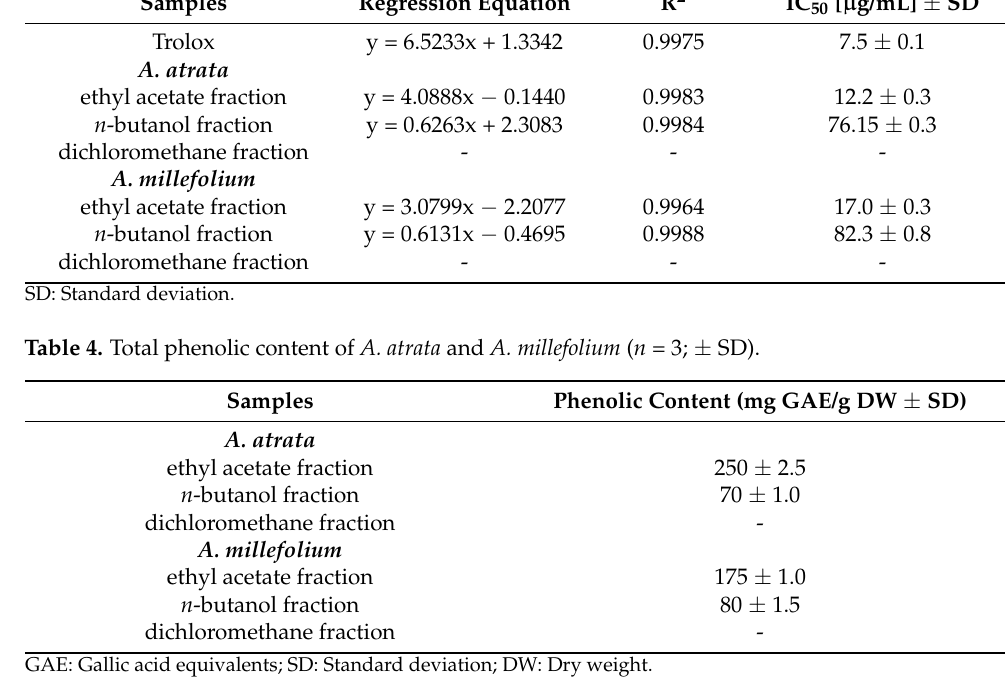
Table 3. Antioxidant capacity of A. atrata and A. millefolium ( n = 3; ± SD). Samples